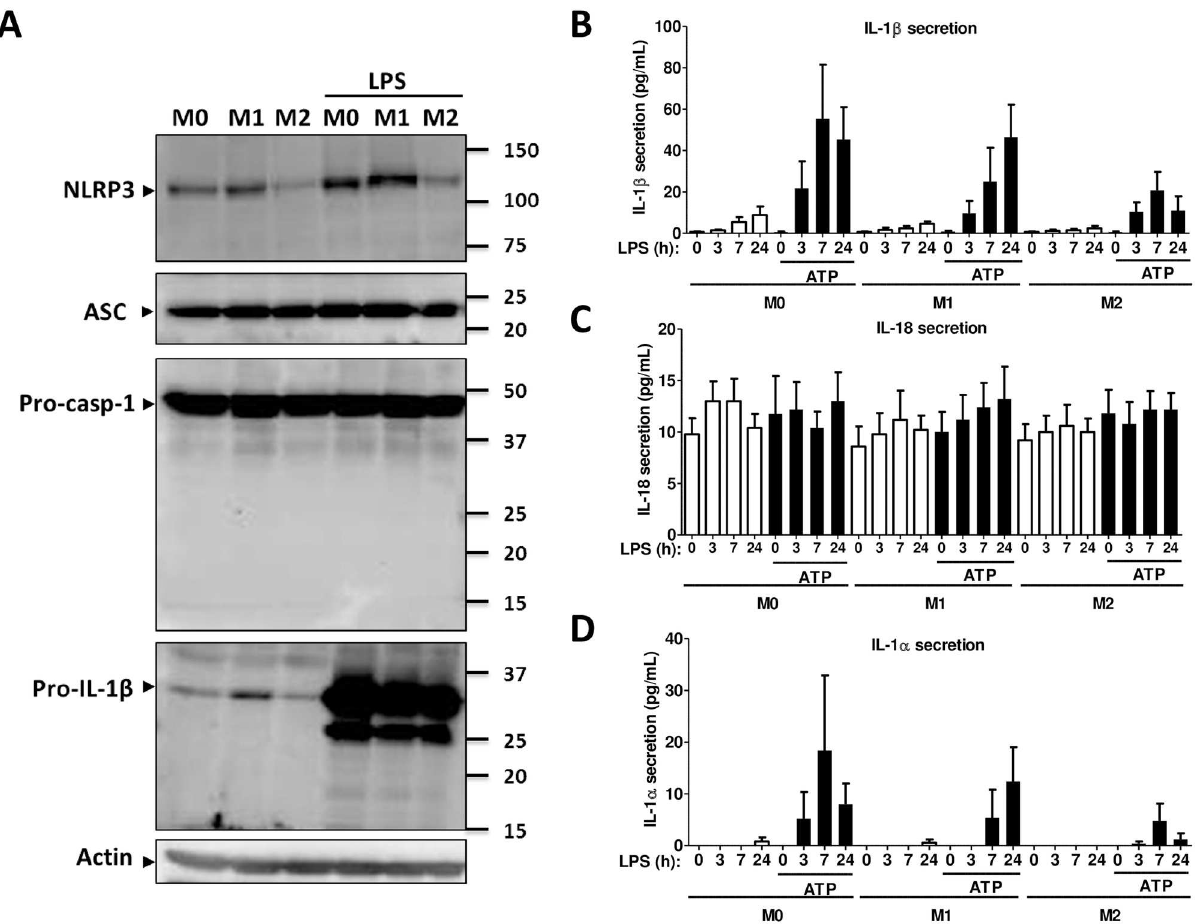
Fig 6. NLRP3 inflammasome protein expression in polarized macrophages. (A) Western blot analysisfrom total cell lysates of M0, M1 or M2 macrophages in the presenceor absenceof LPS using an anti-NLRP3, an anti-ASC, an anti-caspase-1 or an anti-IL-1 β antibody. GAPDH was used as loadingcontrol. Blots are representative of (cid:21) 3 independentexperiments. (B-D) IL-1 β , IL-1 α and IL-18 secretionas assessed by ELISA in cell culture supernatants of M0, M1, or M2 monocytes after activationof NLRP3 inflammasome with 100 ng/ml LPS for the indicatedperiodof times in the presence or absenceof 5mM ATP for the last 30 minutes. M0: cells treated with completemedium (control); M1: cells treated with 100 ng/ml IFN- γ (polarizedtowards M1); M2: cells treated with 10 ng/ml IL-4+IL-13 (polarizedtowards M2). Data represent the mean ± SEM of (cid:21) 4 independentexperiments done in macrophages derived from monocytesof (cid:21) 4 independent donors.